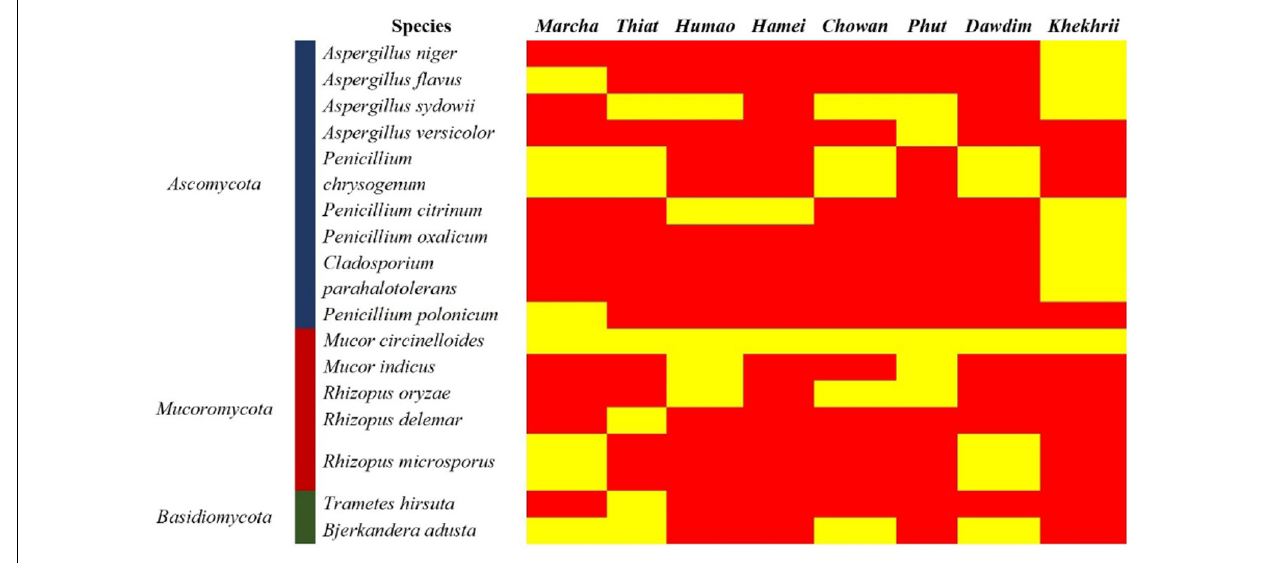
FIGURE 3 | Heatmap showing the consensus species diversity resulted by ITS-region gene sequencing of filamentous fungal isolates. We used presence/absence value for fungal species to generate the heatmap, where the yellow color indicates the presence and red indicates